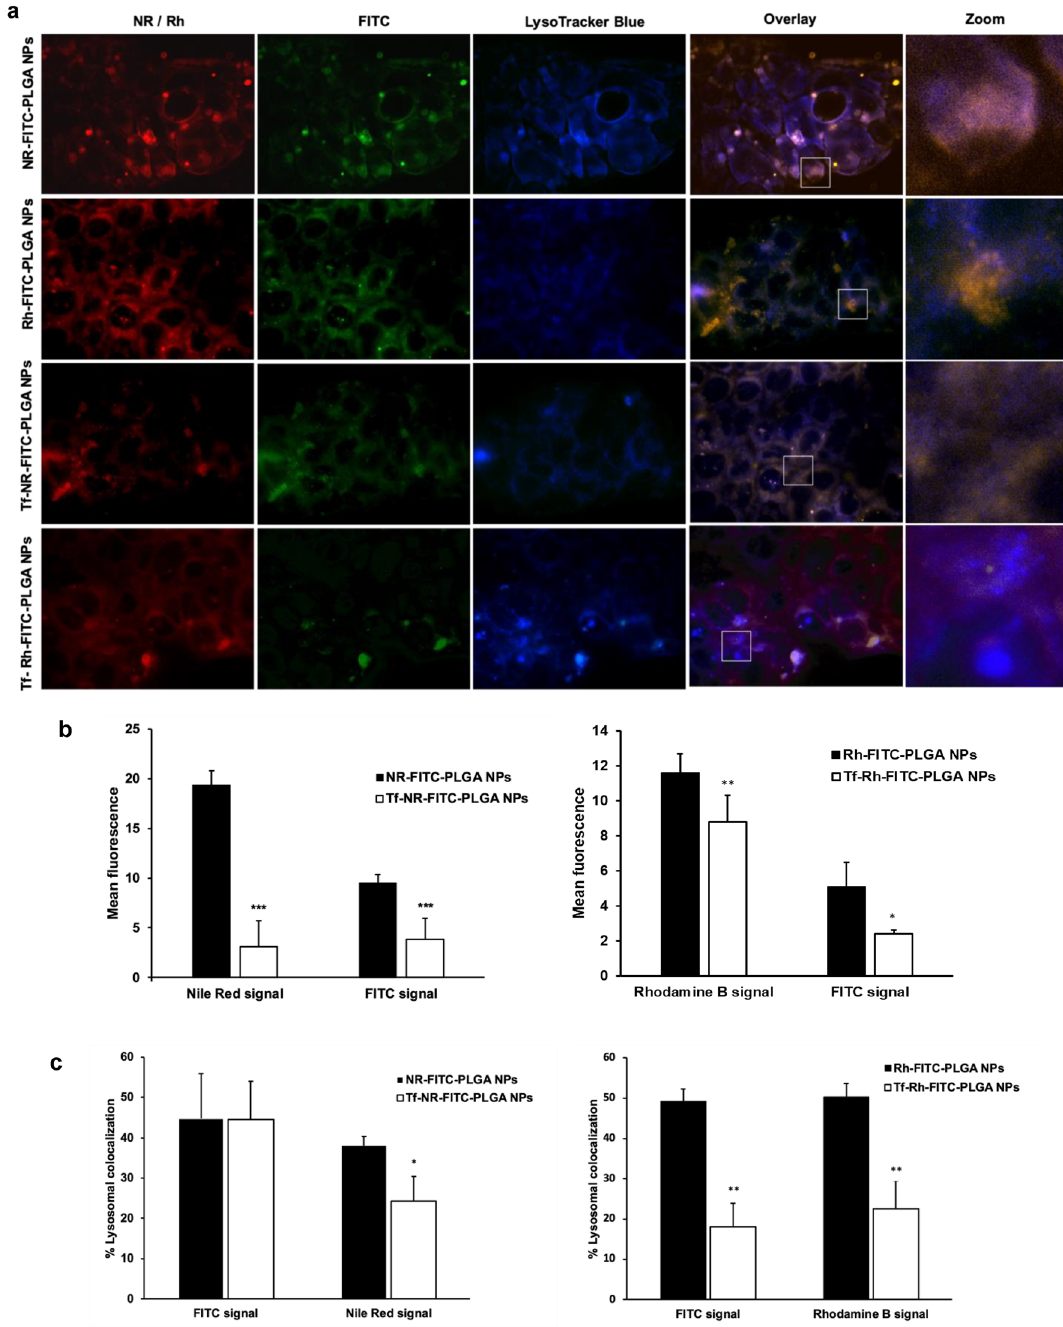
Figure 5. Intracellular trafficking analysis of the formulations upon interaction with the cells. ( a ) Fluorescent microscopy images of Caco-2 cells incubated with NR- and Rh- loaded, FITC-conjugated, plain and Tf-modified NPs for 2 h. Red represents the fluorescence of the loaded fluorophore (i.e. Nile Red or Rhodamine B); green represents the conjugated fluorophore FITC; blue represents lysosomes stained with LysoTracker Blue. The insets highlight a magnified view of the marked areas, showing colocalization of the NPs with lysosomes. ( b ) Percent fluorescence intensity obtained in the images from each fluorophore from plain and Tf-modified formulations. ( c ) Lysosomal percent colocalization. The colocalization analysis was performed with default M1 and M2 coefficients in ImageJ software. Statistically significant differences are highlighted as *p < 0.05; **p < 0.01; ***p <